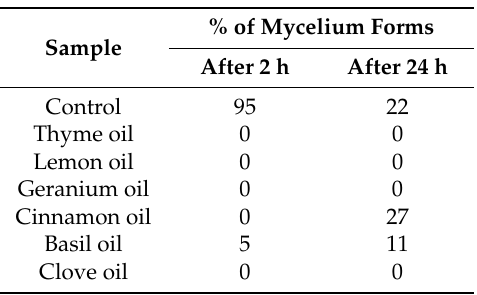
Table 7. The content of hypha forms after EO treatment.